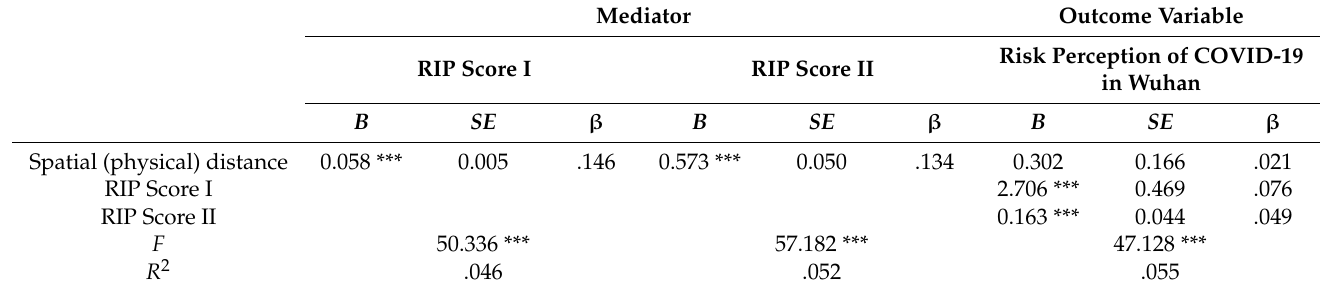
Table 7. Parallel mediation model showing the effects of spatial (physical) distance and risk infor- mation proportion on the risk perception of COVID-19 in Wuhan ( N = 7283, adult data with no missing